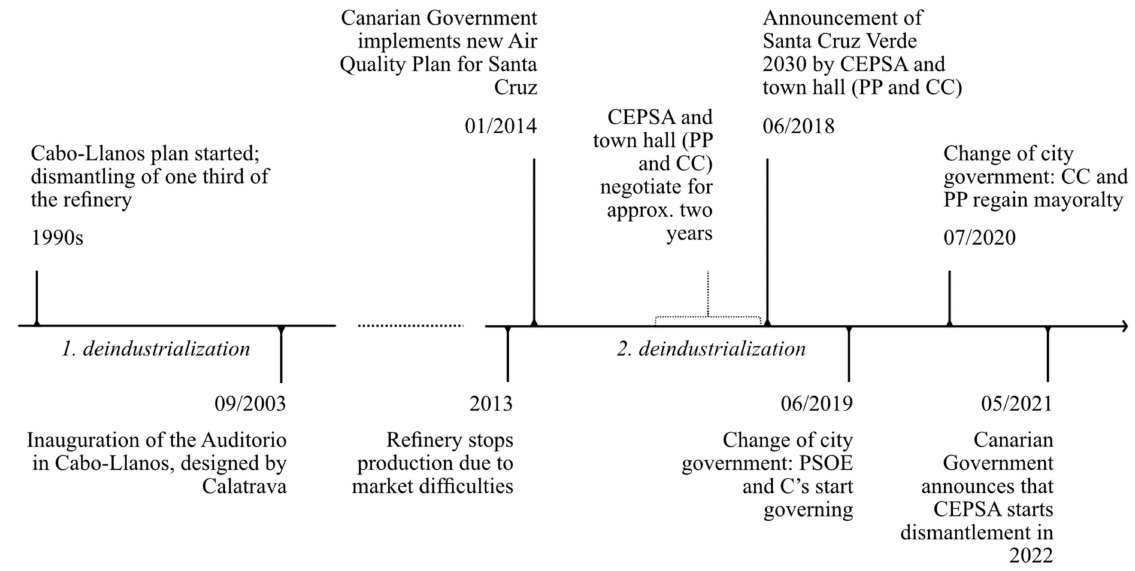
Figure 8. Two waves of deindustrialization dismantling Tenerife’s oil refinery. Own elaboration based on Arencibia de Torres [110], Gobierno de Canarias [114], Ayuntamiento de Santa Cruz de Tenerife [21], Rever ó n [115], and the